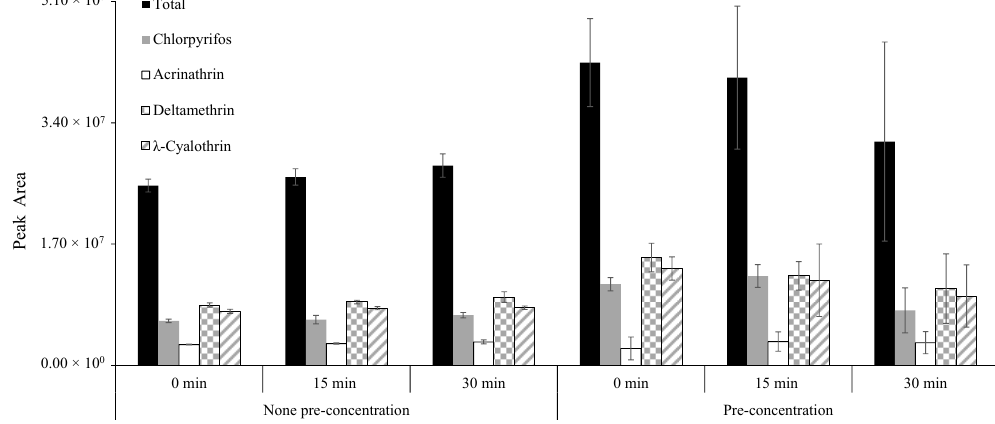
Figure 3. Influence of ultrasound time and pre ‐ concentration until dryness on insecticides extraction.